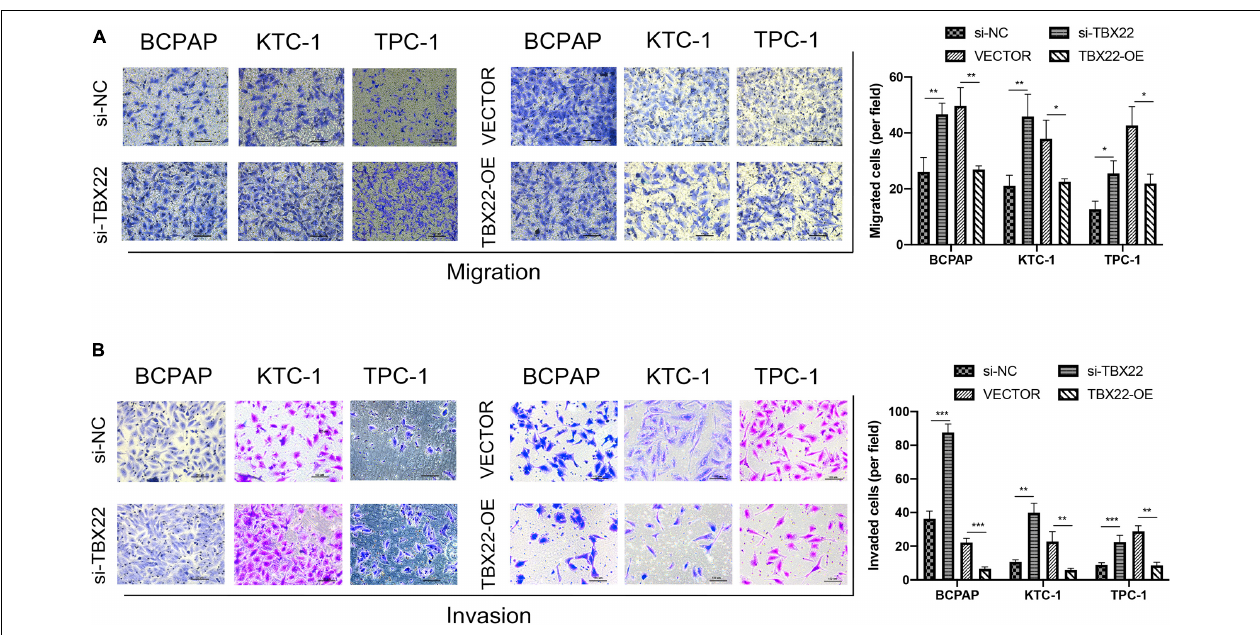
FIGURE 10 | TBX22 inhibited the migration and invasion of PTC cell lines. (A,B) Loss-of-function and gain-of-function assays indicated that TBX22 reduced the (A) migration and (B) invasion abilities of PTC cell lines. * p < 0.05, ** p < 0.01, *** p < 0.001 in comparison with the si-NC or VECTOR groups using Student’s t -test, and all assays were repeated at least three